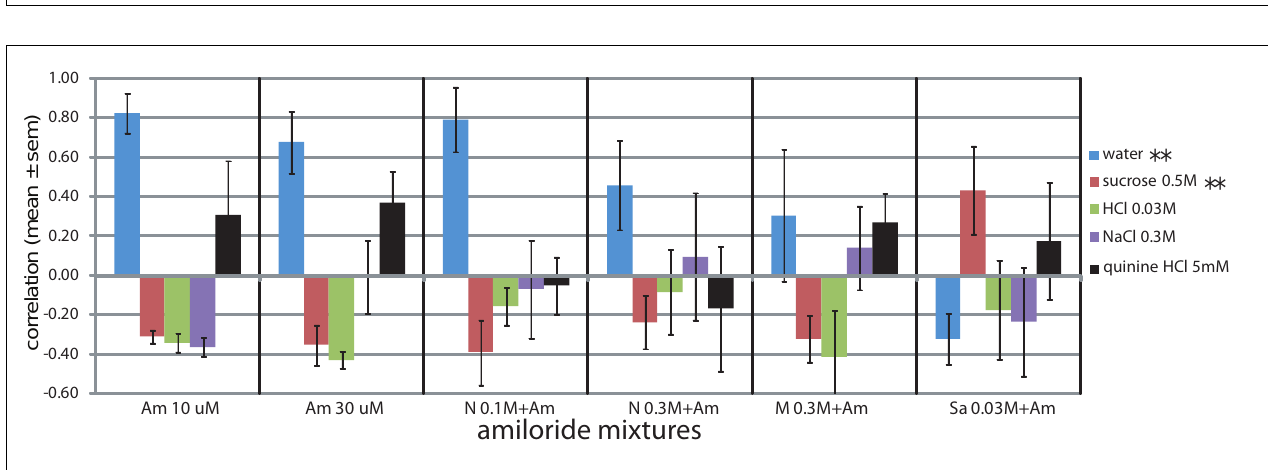
FIGURE 6 |Amiloride addition blocks generalizations to salt. * P < 0.05, ** P < 0.01, *** P < 0.001 (MANOVA on concentration).